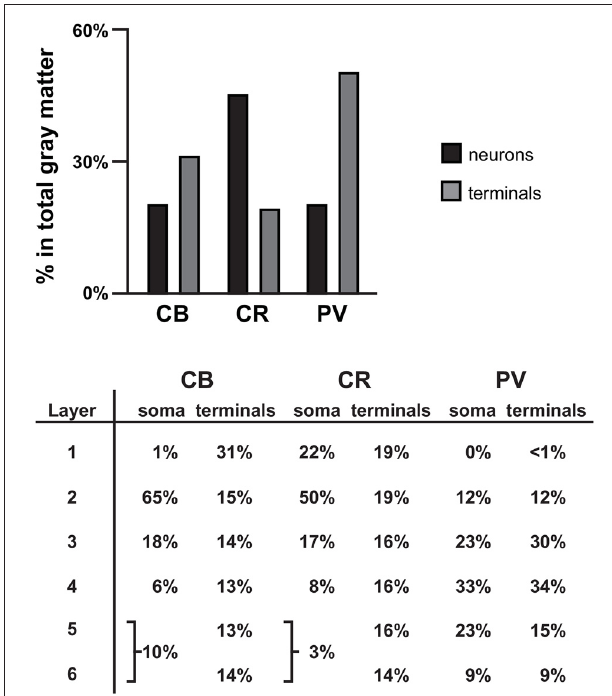
FIGURE 6 | Summary. Bar graph showing the percentage of all γ -aminobutyric acid (GABA) neurons (black bars) and terminals assessed (gray bars) that is CB+, CR+, or PV+ in PFC total gray matter. Table showing the distribution of soma and terminals for each of the three GABA neuron subtypes across the six cortical layers. The soma data for CB and CR were taken from previously published findings in human PFC (Daviss and Lewis,